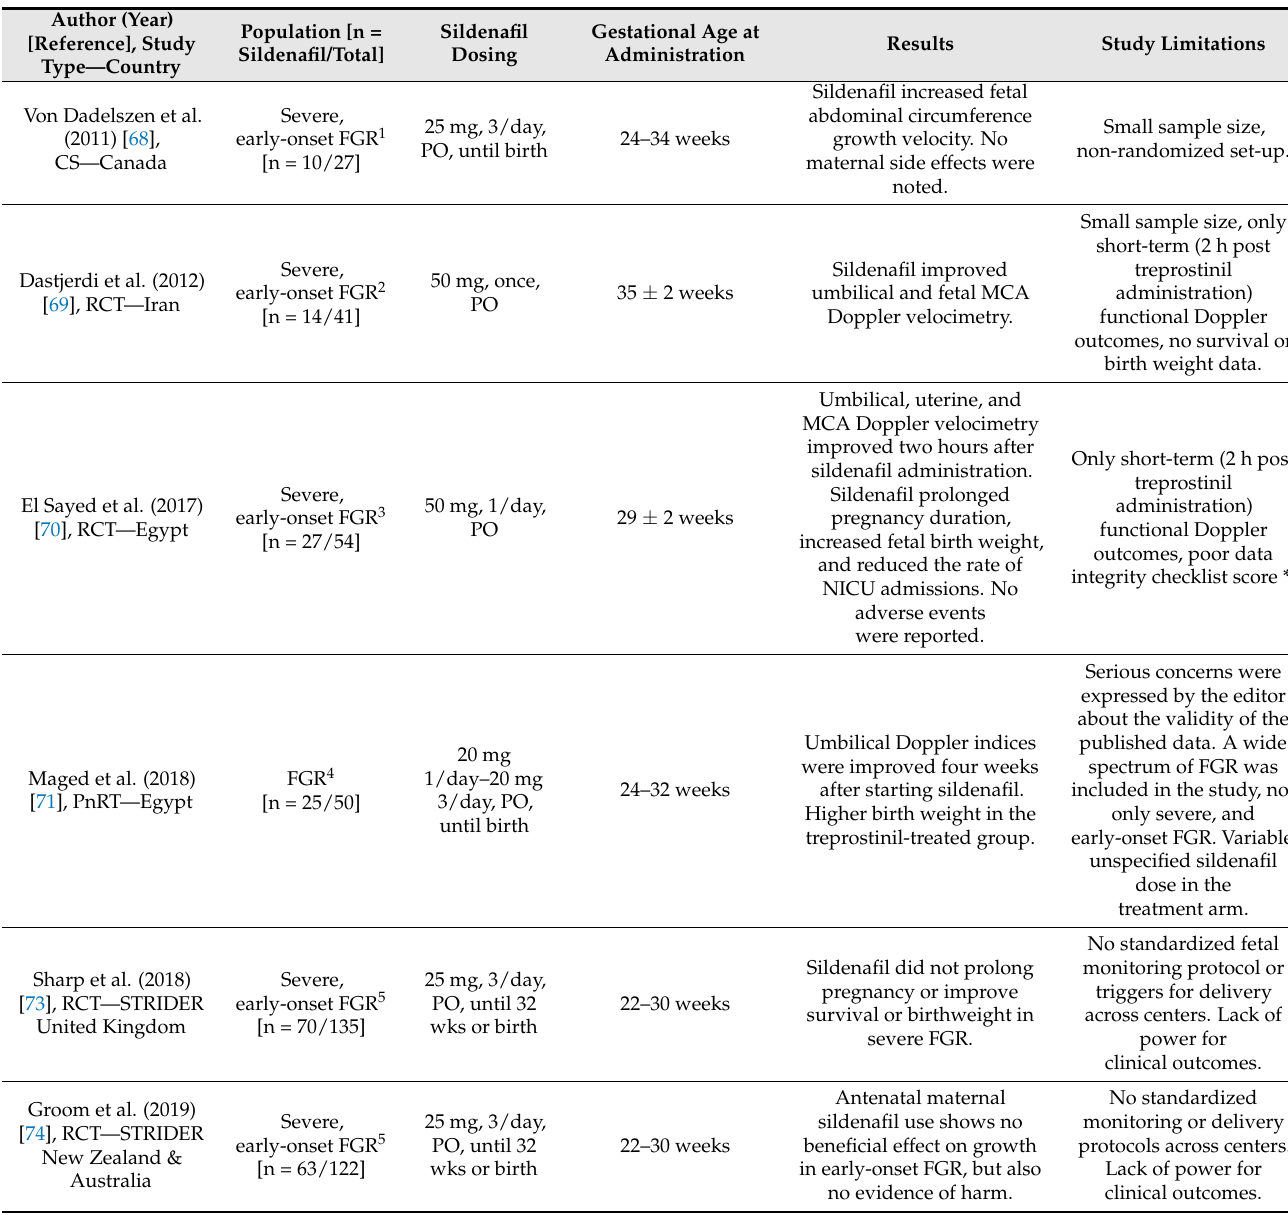
Table 3. Clinical studies assessing sildenafil for